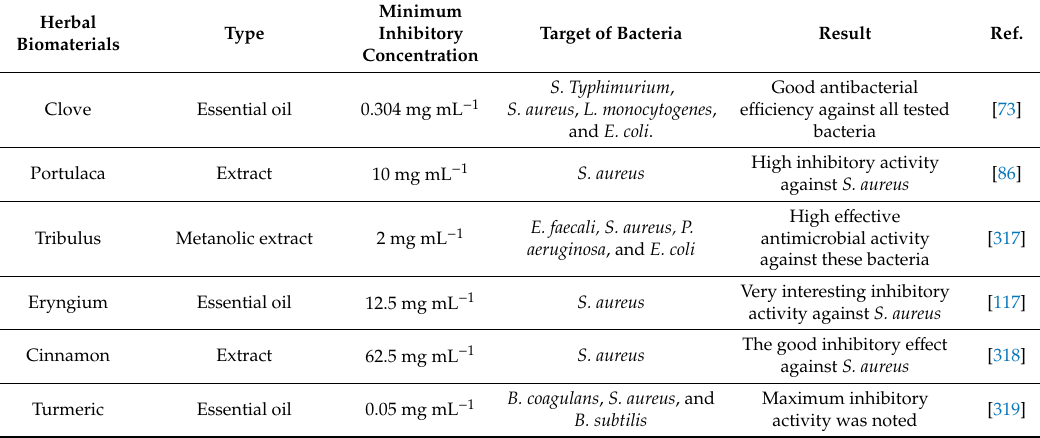
Table 2. The herbal antimicrobial agents developed and their